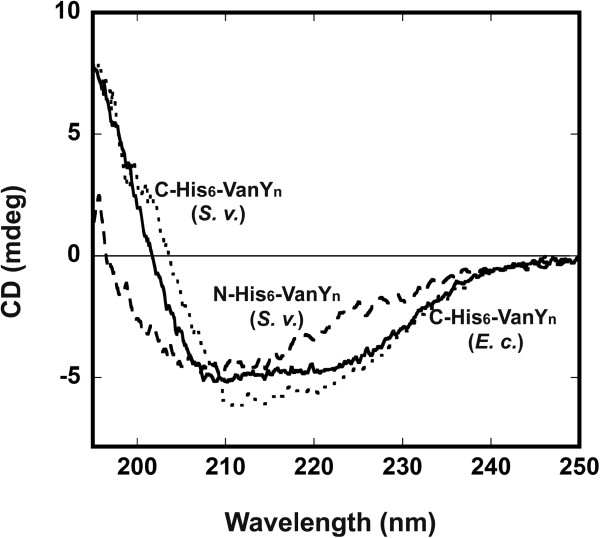
Far-UV CD spectra of recombinant VanYn. C-His6-VanYn (dotted line) and N-His6-VanYn (dashed line) from recombinant S. venezuelae (S. v.); C-His6-VanYn from recombinant E. coli (E. c.) (continuous line). Protein concentration was 0.1 mg/mL, 15°C.